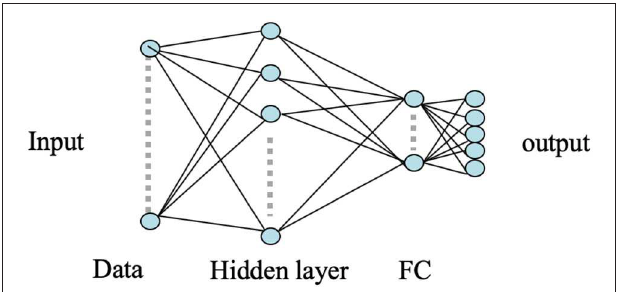
FIGURE 4 | ANN architecture. Here the circles represent the nodes whereas the arrows represent the connections between the nodes. The input layer is an 1,176 dimensional feature vector. The hidden layer consists of 256 nodes and the remaining layers are of 5 nodes.